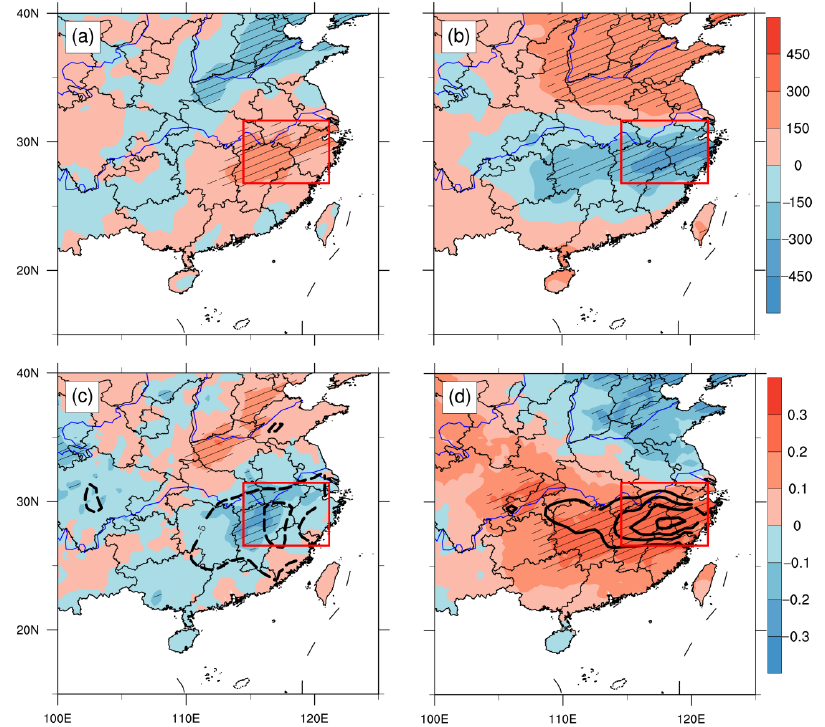
Figure 12. Composite average anomalies of surface solar radiation downwards (( a , b ); unit: kJ m −2 ; shadings), total cloud cover (( c , d ); unit: 0–1; shadings) and averaged precipitation anomalies (( c , d ); contours are from −20 mm to 20 mm with interval of 5 mm) during the SR+ ( a , c ) and SRP− ( b , d ) events. The slash shadings indicate that the anomalies of surface solar radiation downwards ( a , b ) and total cloud cover ( c , d ) are statistically significant at the 0.05 confidence level. Red rectangles denote the YRV (114–122° E, 27–32° N) regions. Only negative and positive precipitation anomalies are plotted in Figure 14c,d, respectively.